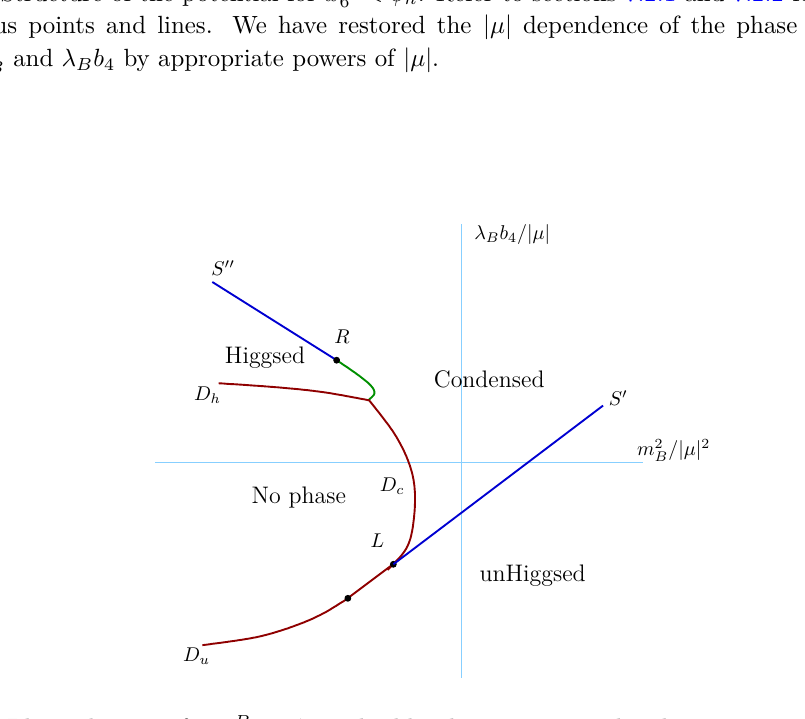
Figure 34 . Phase diagram for x B < φ h . The blue lines are second order transitions, the green 6 line is a first order transition while the red lines demarcate regions of runaway potential from the regions where metastable phases exist. Recall that the potential is unstable and all the phases displayed above are metastable at best. We have restored the | µ | dependence of the phase diagram by rescaling m 2 and λ B b 4 by appropriate powers of | µ | B